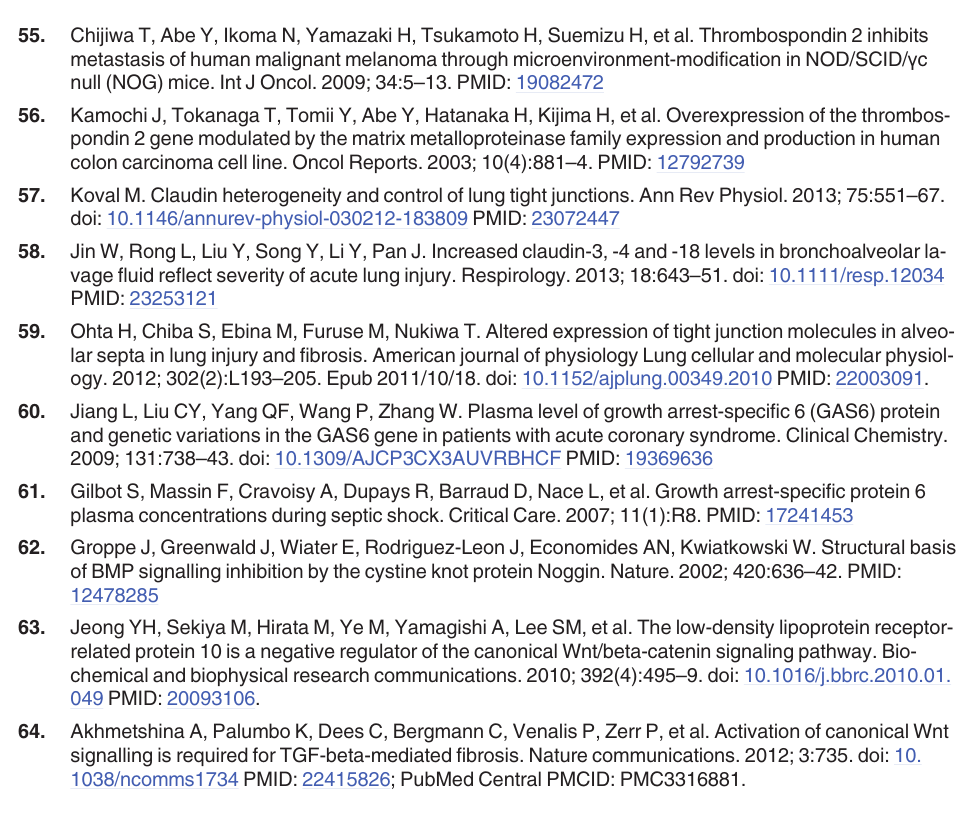
PLOS ONE | DOI:10.1371/journal.pone.0118459 February 24,